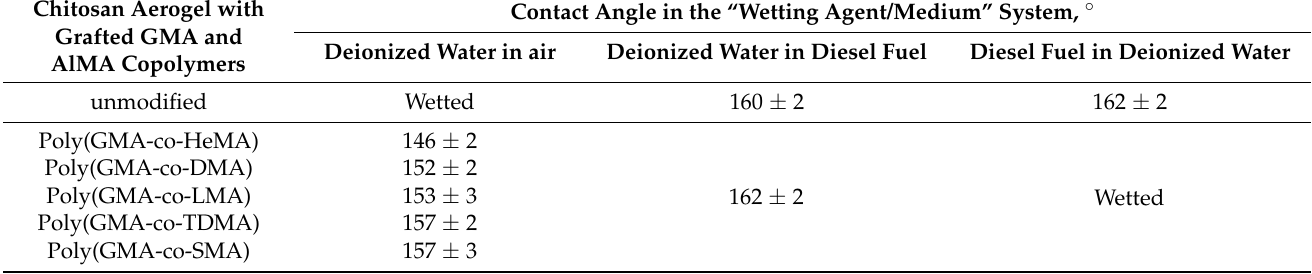
Table 8. Wettability of chitosan aerogels as a result of modification with GMA and AlMA copolymers. Chitosan Aerogel with Contact Angle in the “Wetting Agent/Medium” System, ◦ Grafted GMA and Deionized Water in air Deionized Water in Diesel Fuel Diesel Fuel in Deionized Water AlMA Copolymers unmodified Wetted